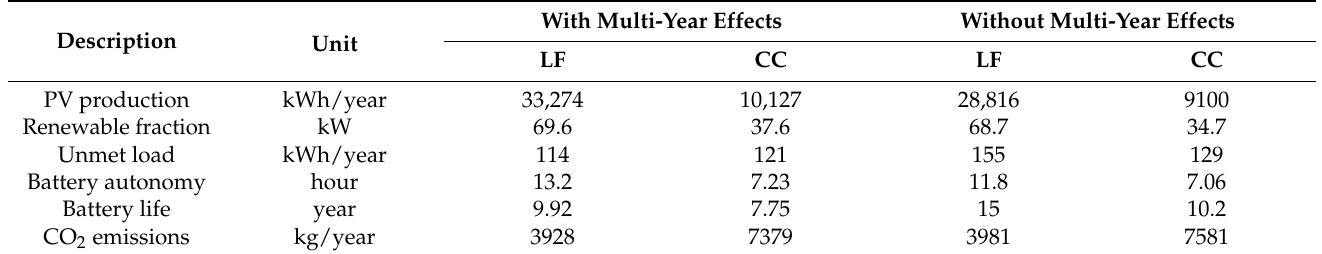
Table 6. Technical and environmental specifications of the HES using different control strategies.